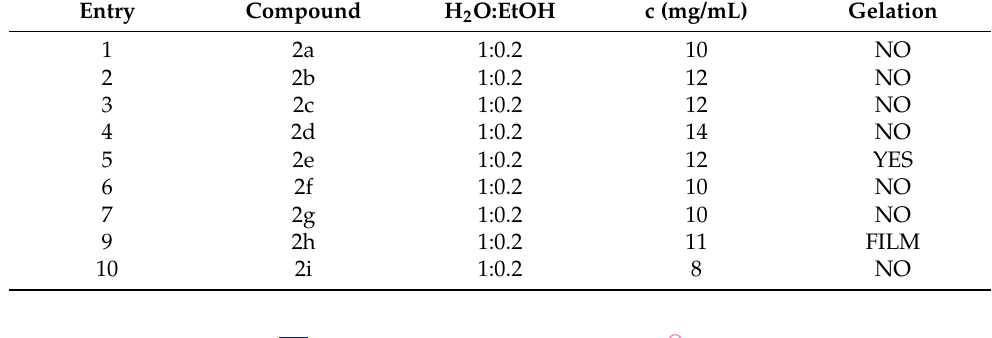
Figure 4. Peptidomitic pyrrolidinone derivatives tested as gelators. Table 2. Gelation test of peptidomimetics 2a–i.